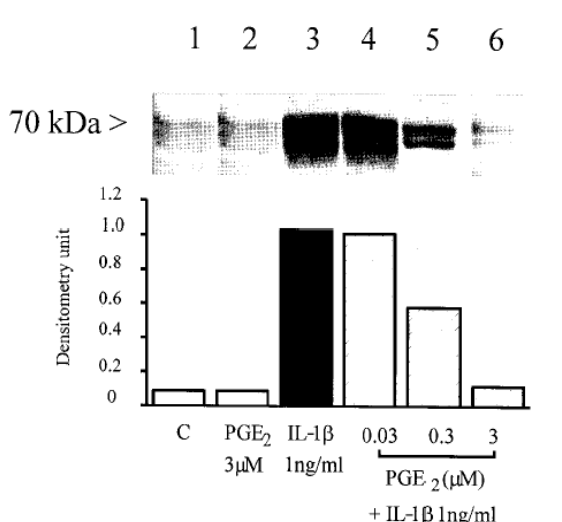
FIG. 3. The effects of PGE 2 on COX-2 protein expressed in IL- 1 b (1ng/ml) treated HUVEC. COX-2 protein was detected by Western blots using polyclonal antibodies to COX-2 in cell extracts of HUVEC treated with no addition (lane 1), PGE 2 (3 m M) alone (lane 2), IL-1 b (1ng/ml) alone (lane 3) or IL-1 b (1ng/ml) plus PGE 2 (0.03, 0.3 or 3 m M; lane 4 to 6) for 24h. Equal amounts of protein (20 m g/lane) were loaded in each lane. Similar results were obtained with cell extracts from three separate batches of cells. The significant differences between each band were compared by scanner densito- metry using image 1D program (densitometry unit).